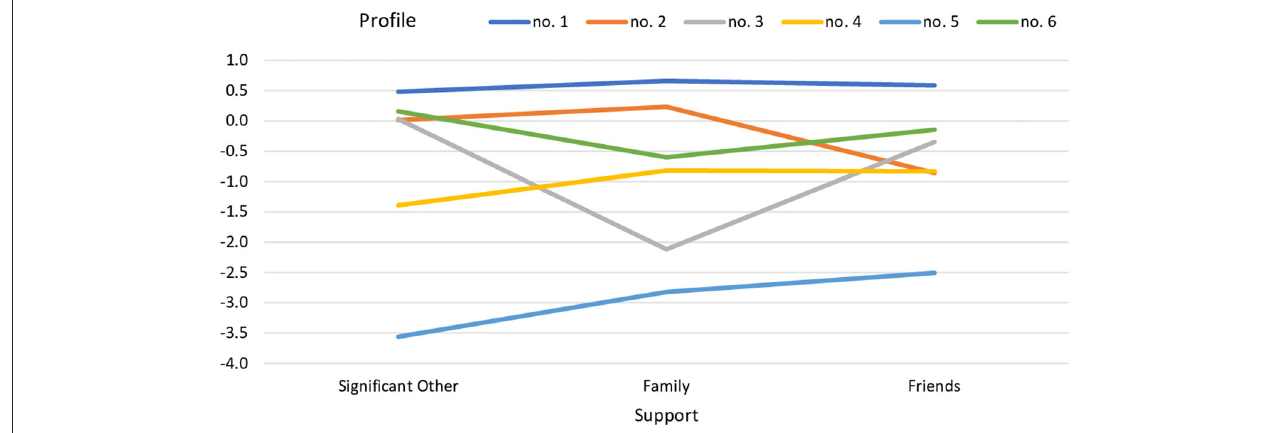
FIGURE 1 | Profiles of perceived support in the group of pregnant women.